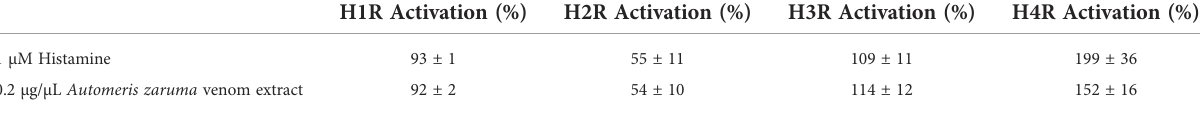
TABLE 1 % Activation by histamine and A. zaruma venom extract at H1R, H2R, H3R and